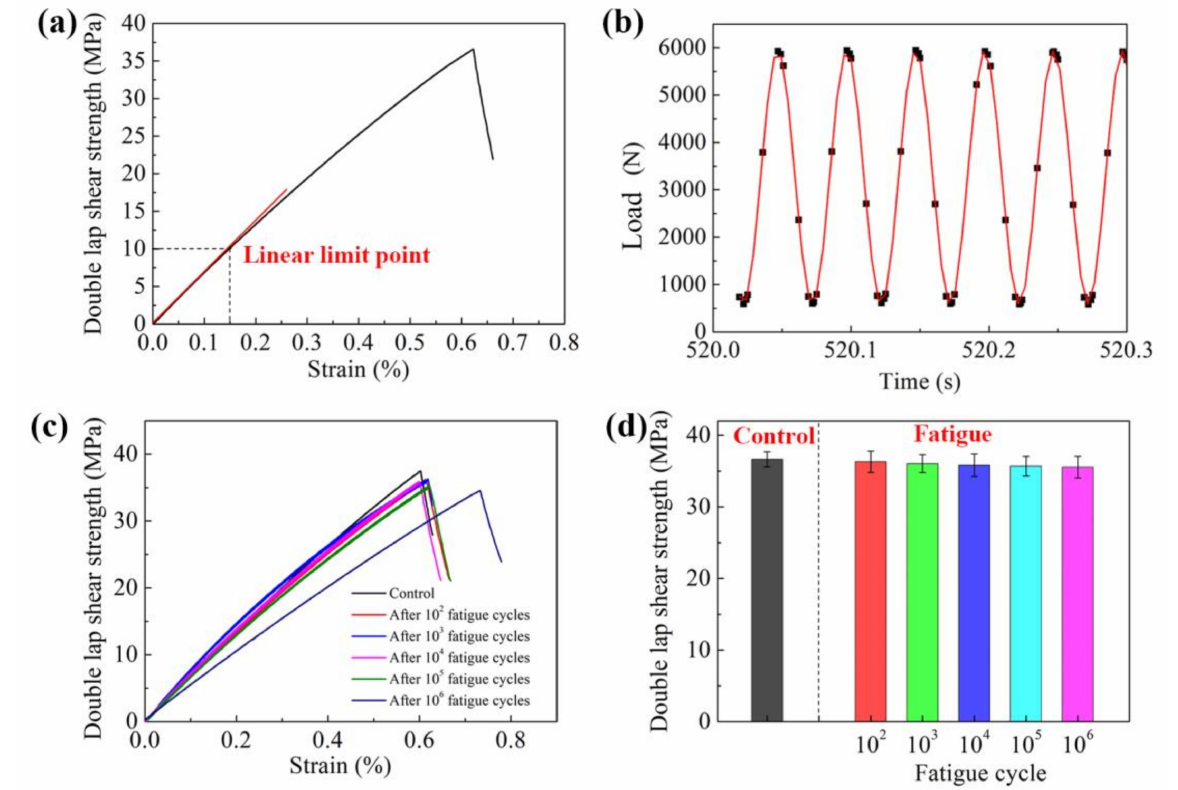
Figure 9. Fatigue performance of Ep/PHO30/nBN30 structural film adhesive: ( a ) stress–strain curve at room temperature, ( b ) dynamic load loading mode, ( c ) stress–strain curves after different fatigue tests, and ( d ) residual shear strength after fatigue